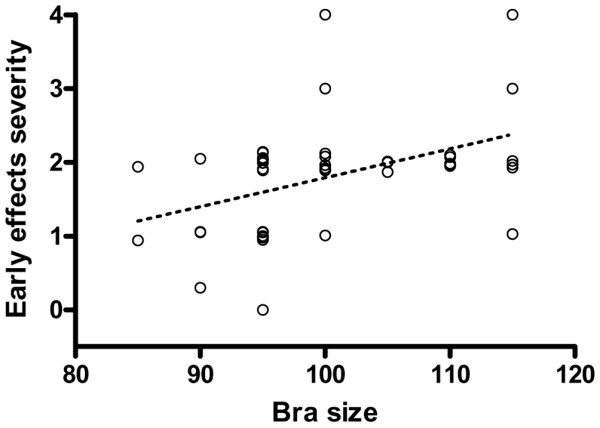
Relation between estimated irradiation volumes and severity of early effects of radiotherapy for breast cancer. Irradiation volumes were estimated from the women's bra size, and the severity of the early effects were scored in the same women (n = 50). Dotted line shows the corresponding regression line (P < 0.001).